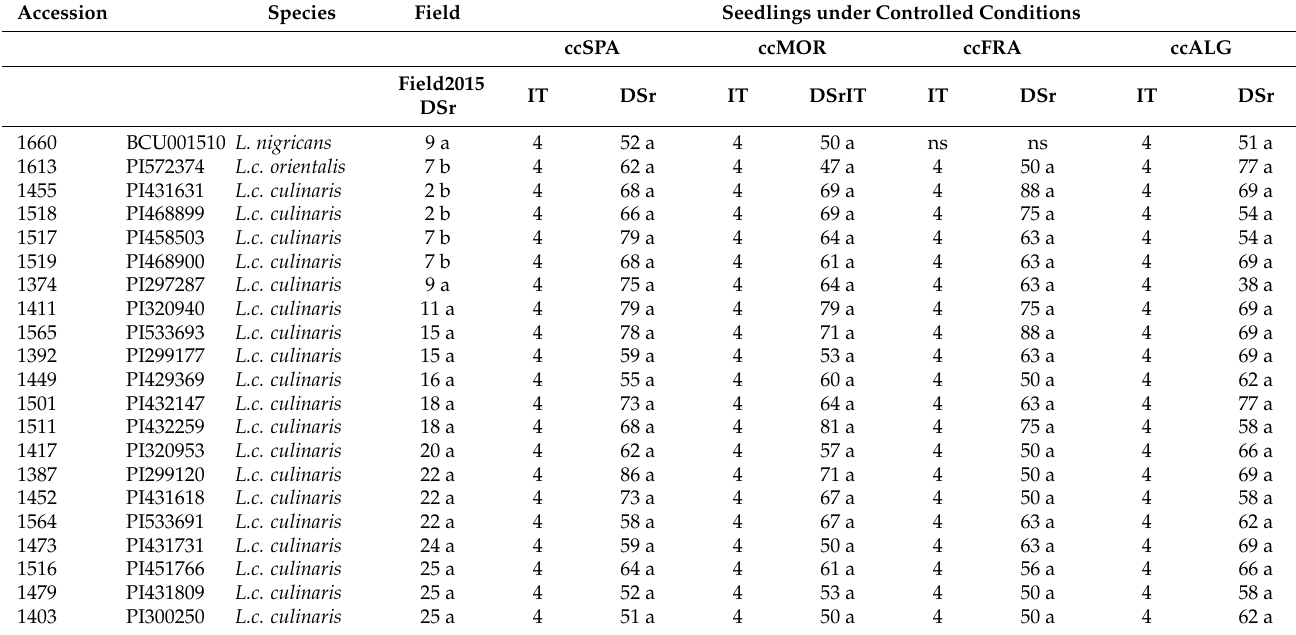
(Table 8) showing reduced severity in adult plants in the field (DSr < 20%), whereas they were highly susceptible in seedlings against all isolates (IT > 3, DSr > 50%). Table 8. Selection of candidates for adult plant resistance against U. viciae-fabae ex L. culinaris , susceptible in seedlings (IT > 3, DSr > 50%) but resistant in adult plants in the field (DSr < 20%). Data with the same letter per column are not significantly different (LSD test, p <